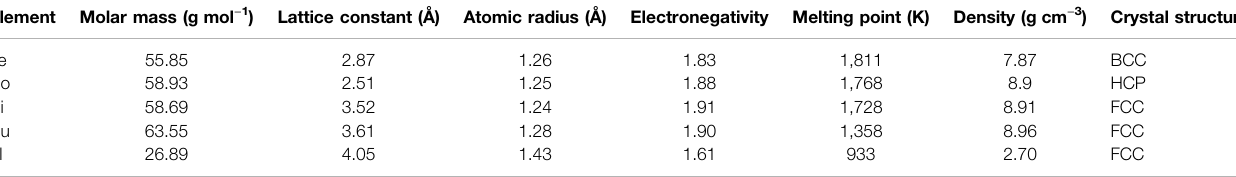
TABLE 1 | Characteristic parameters of alloy